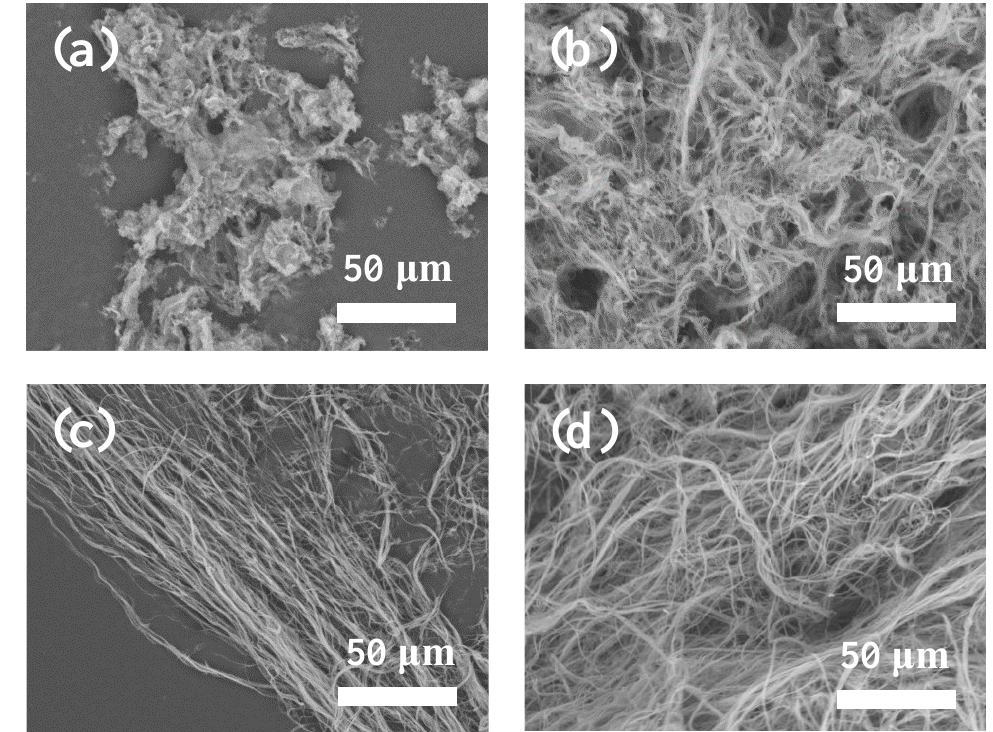
Figure 5. SEM images of the products synthesized using ATP as a bio-phosphorus source in aqueous solution by the calcium oleate precursor microwave hydrothermal method at 180 °C for different times: ( a ) 10 min; ( b ) 20 min; ( c ) 30 min; ( d ) 60 min.